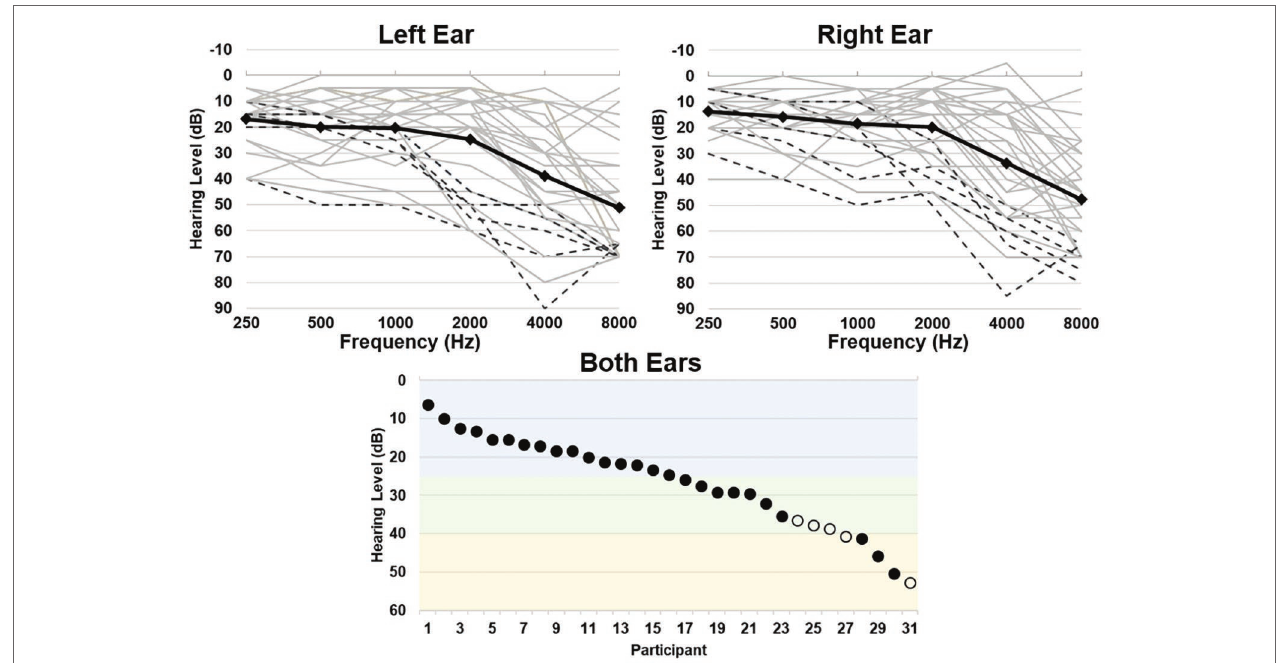
FIGURE 1 | Hearing thresholds as assessed by pure-tone audiometry. Top left and right panels depict average thresholds for each ear, respectively. Individual participant thresholds are shown in light gray, individuals who wear hearing aids are shown in black dashed lines, and group average thresholds are shown in the black solid line. Bottom panel depicts the average threshold across all frequencies for both ears per participant, depicting a range of normal hearing levels (blue), mild (green), and moderate (yellow) hearing loss (Clark, 1981). Individuals who wear hearing aids are shown in open